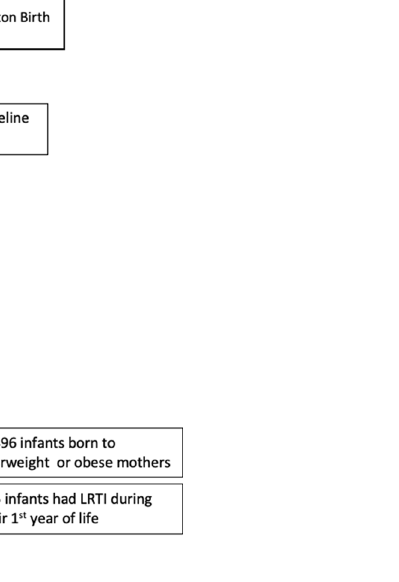
Figure 1. Study Population and